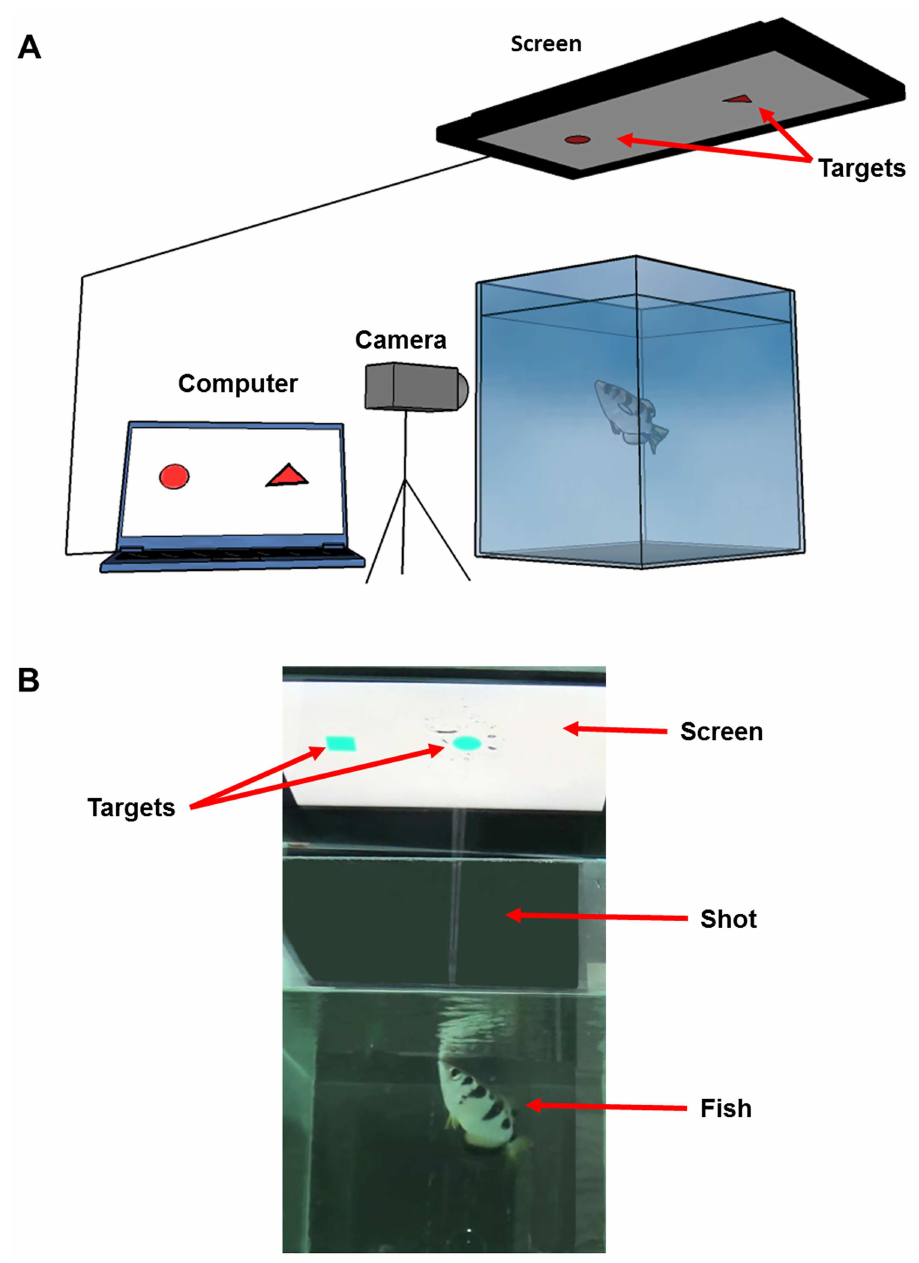
Fig 1. Experimental setup. A. Schematic representation of the experimental setup and the recording system. B. Photo of a real experiment (the black backgroundwas made darker by image manipulation to show the shot